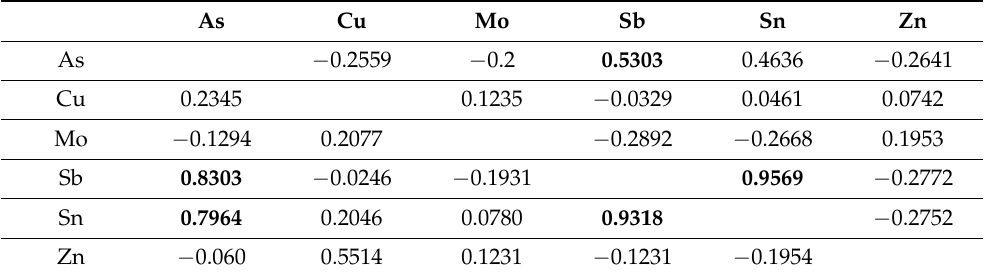
Table 2. Correlations (Pearson and Spearman) between elements of potential environmental concern. The significant ones at a 95% confidence lever are in